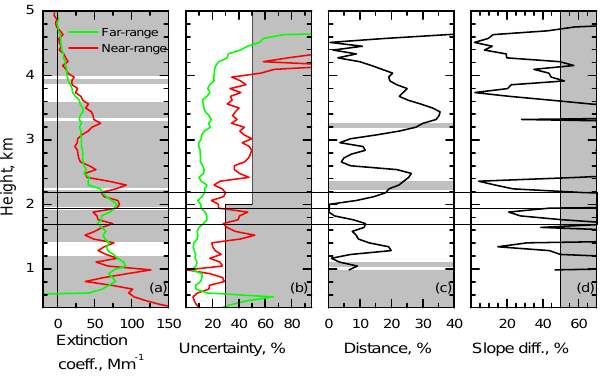
Figure 8. Illustration of the search for the merge region. Red and green curves in (a) and (b) are the extinction profiles and its relative statistical uncertainties with maximum vertical smoothing. (c) and (d) show the mean relative distances and slope differences of the moving merge windows. Gray area in (b) illustrates the error thresh- old. Gray areas in (c) mark height ranges where the profiles do not overlap within their uncertainties. Gray areas in (d) indicate height regions where the slope difference is larger than the threshold of 50%. Gray areas in (a) show all height ranges where one or more of the quality criteria of the search for the merge window are not fulfilled. Horizontal thin black lines indicate the position of bottom, center (merge point), and top of the merge